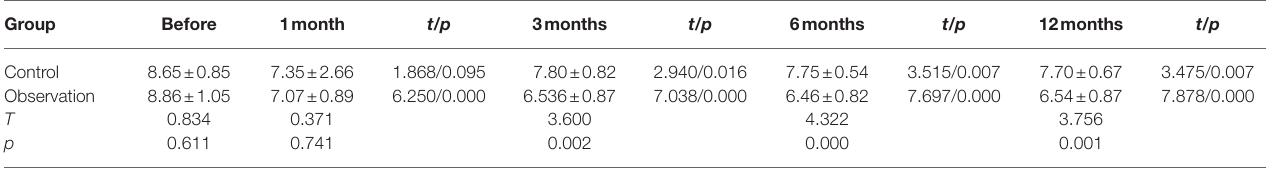
TABLE 5 | The serum FBG levels in the two groups before and after ABMI (mean ± SD, mmol/L). Group Before 1 month